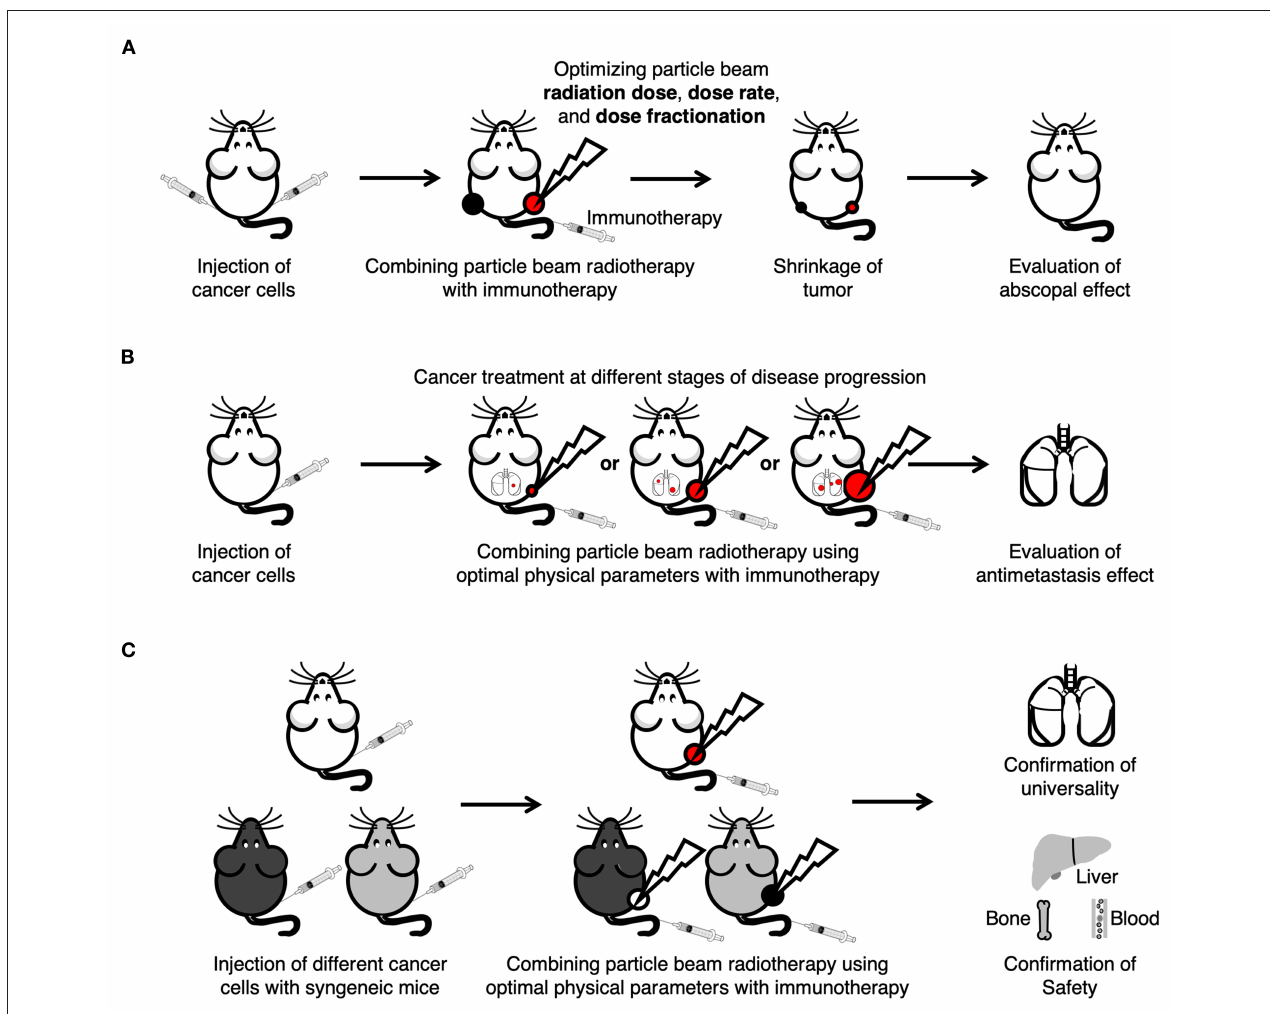
FIGURE 2 | Future preclinical antimetastasis studies of particle beam radiotherapy combined with immunotherapy. (A) Enhancement of the abscopal effect by optimizing the particle beam physical parameters, such as radiation dose, dose rate and dose fractionation. (B) Evaluation of antimetastasis effects that correspond to different primary tumor disease progression levels after combining particle beam radiotherapy using optimal physical parameters with immunotherapy. (C) Confirmation of universality and safety of combination therapy by tumor-bearing syngeneic mice models.